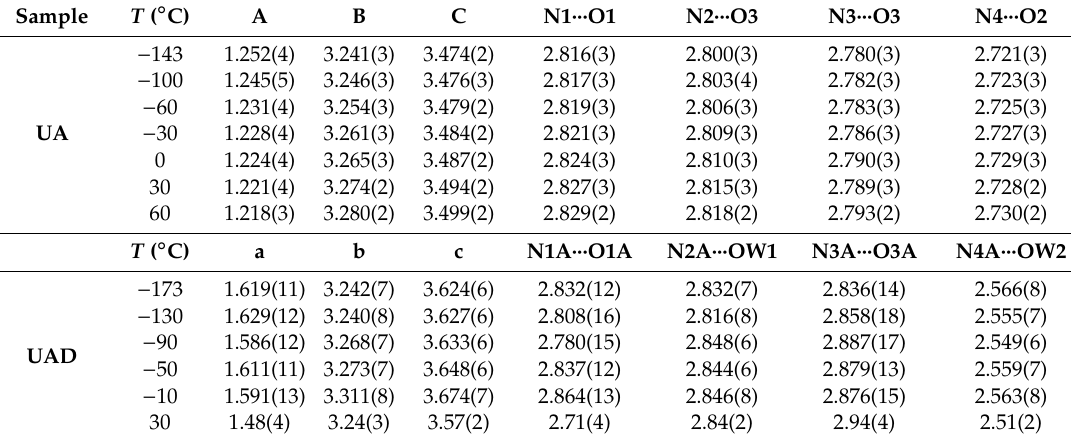
Figure 4. Crystal structure of UA, projections along ( a ) [100], ( b ) [210], and ( c ) [210] directions; and ( d ) the arrangement of the figure of thermal expansion/contraction coefficients (TEC) in the structure of UA. Legend the same as in Figure 2; TEC figures: expansion = green, contraction = red. Table 2. Alteration of selected interatomic distances as a function of temperature in the structures of UA and UAD: plane-to-plane shift (A), plane-to-plane normal (B), and centroid-to-centroid distance (C) are the parameters of π -stacking (Figure 3c), and N ··· O are the donor-acceptor distances in the H-bonding systems (values are given only for counterpart with higher occupancy).